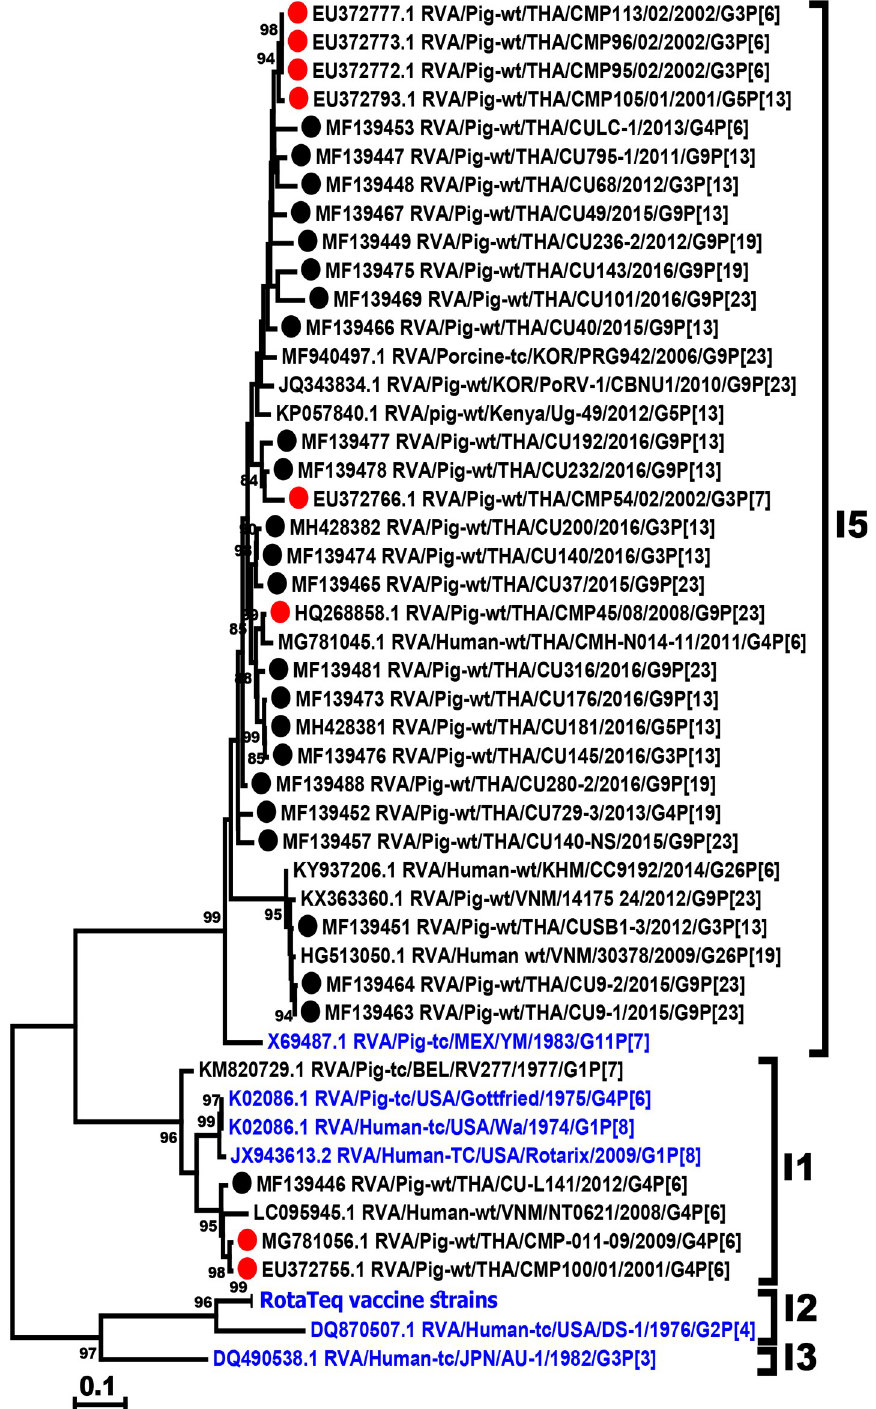
Fig 3. Phylogenetic analysis of the RVA VP6 gene. The nucleotide sequences of the Thai strains (dotted) were compared to those of previous Thai porcine RVA strains (red dotted), the RVA reference and vaccine strains (blue).